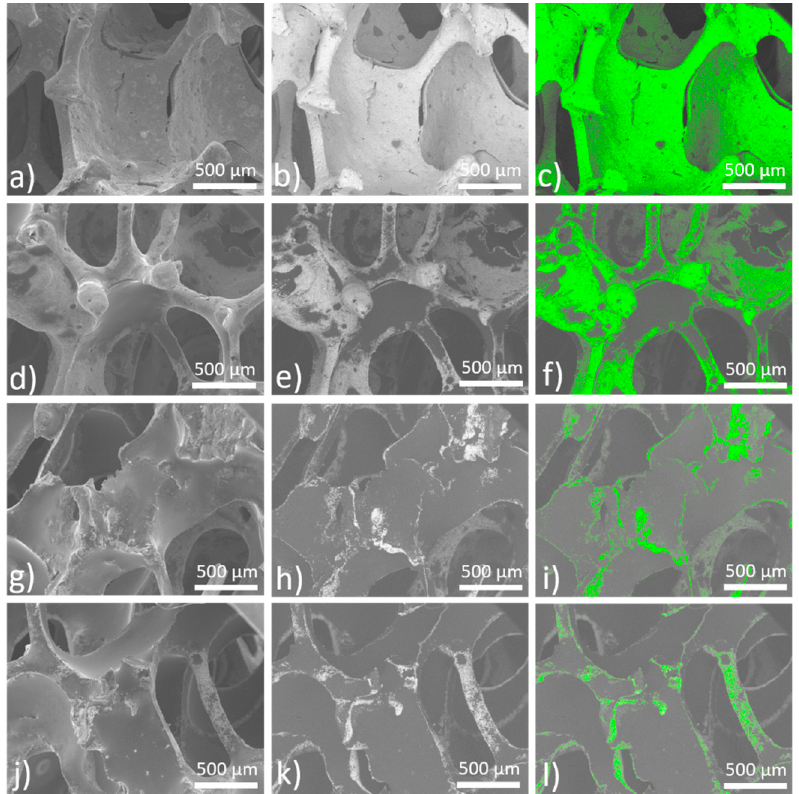
Figure 3. SEM micrographs of the prepared ( a – c ) Fe; ( d – f ) Fe-PEI1; ( g – i ) Fe-PEI2; and ( j – l ) Fe-PEI3 materials. Iron matrix is highlighted in green for better contrast in ( c , f , i , l ).